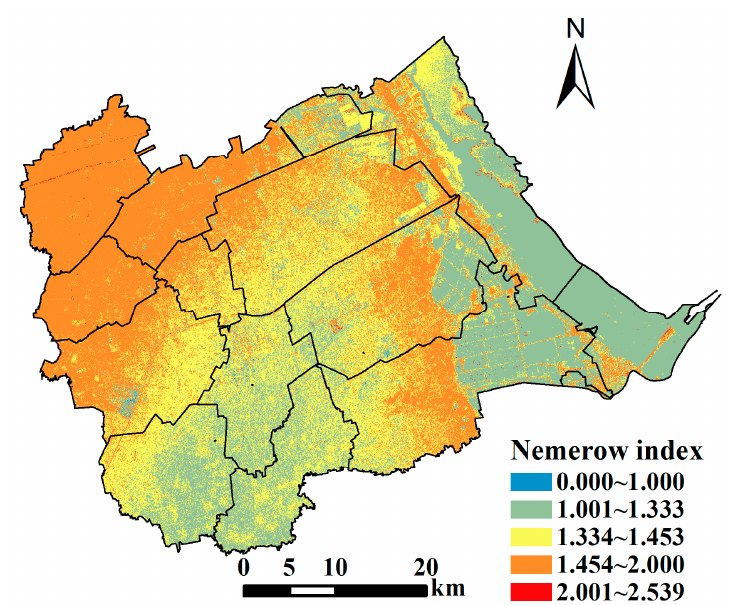
Figure 6. The comprehensive pollution index in Huanghua.